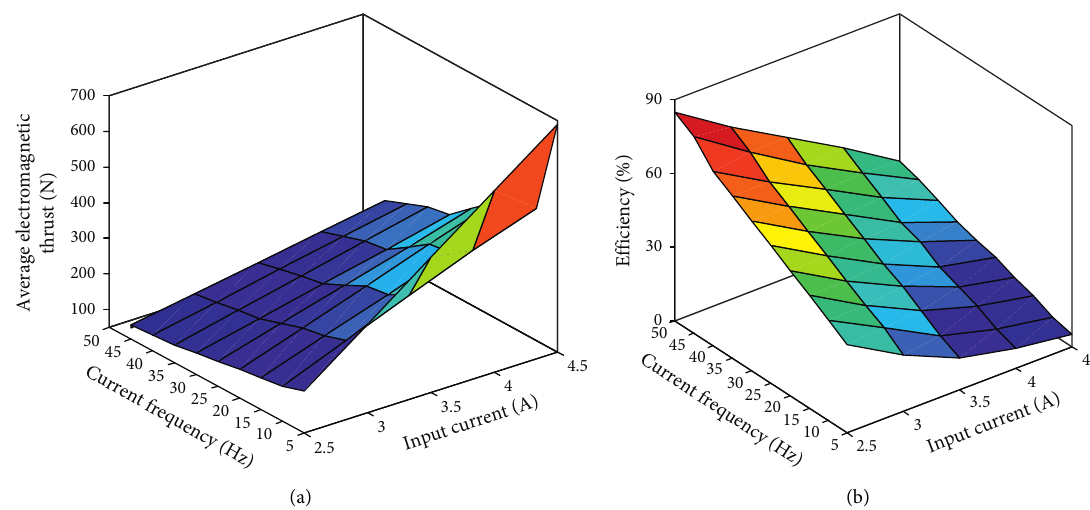
Figure 14: Distribution of average electromagnetic force and efficiency. (a) Average electromagnetic thrust force. (b) Output